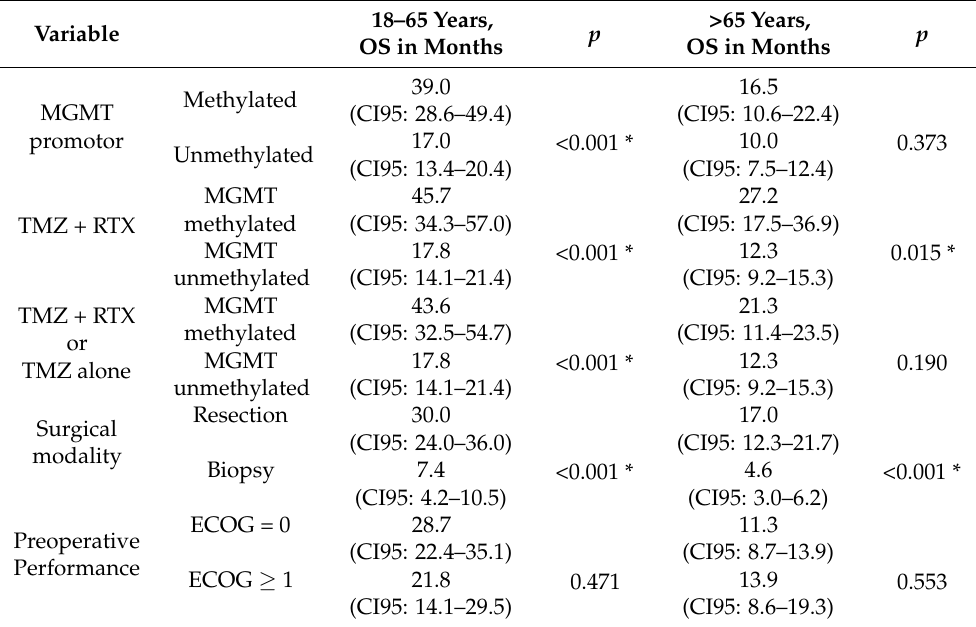
Table 3. Mean estimated OS in comparison between older (more than 65 years) and younger patients (18 to 65 years) in relation to MGMT promotor methylation status, adjuvant therapy, surgical modality and preoperative